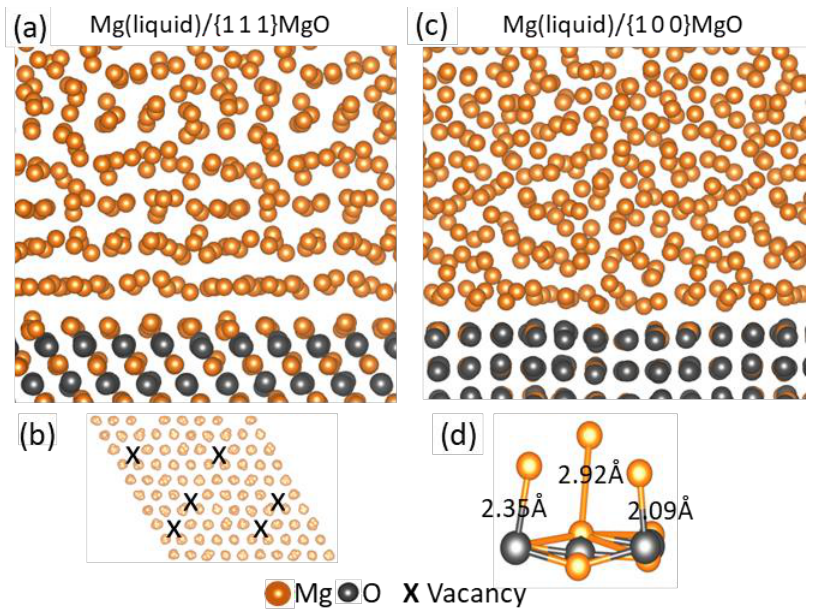
Figure 26. Ab initio molecular dynamics (AIMD) simulation of Mg/MgO interface [82]. ( a ) Mg(l)/MgO{1 1 1} and ( c ) Mg(l)/MgO{0 0 1} interfaces showing atomically rough; ( b ) the first liquid Mg layer induced by the usually O-terminated MgO{1 1 1} substrate, containing vacancies as marked by the “x”; and ( d ) the first liquid Mg layer induced by the MgO{0 0 1} substrate, showing atomically rough due to the varying bond lengths between liquid Mg atoms and the O and Mg ions on the MgO{0 0 1} surface.